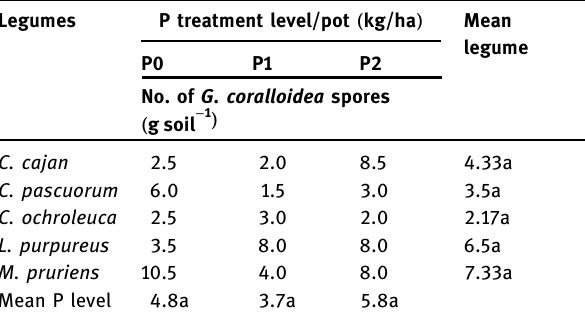
Table 7: E ff ect of phosphorus levels and studied legume species on spores of G. coralloidea Legumes